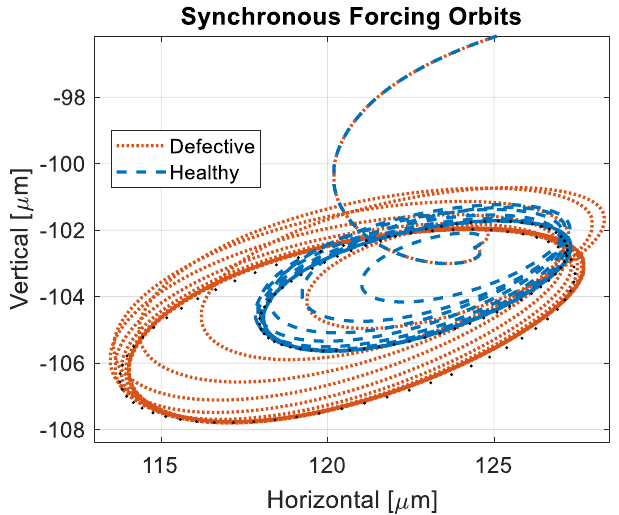
Fig. 6. Orbits due to a synchronous harmonic forcing (cid:1) the black dots represent truly elliptical